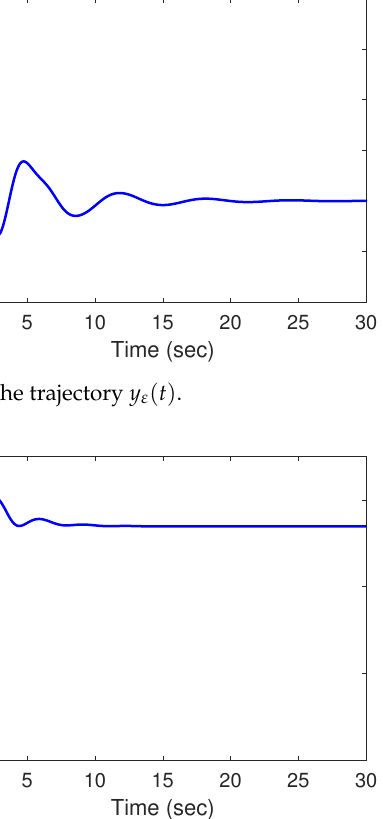
(cid:114) (cid:82) t r y T ε ( t ) y ε ( t ) dt 0